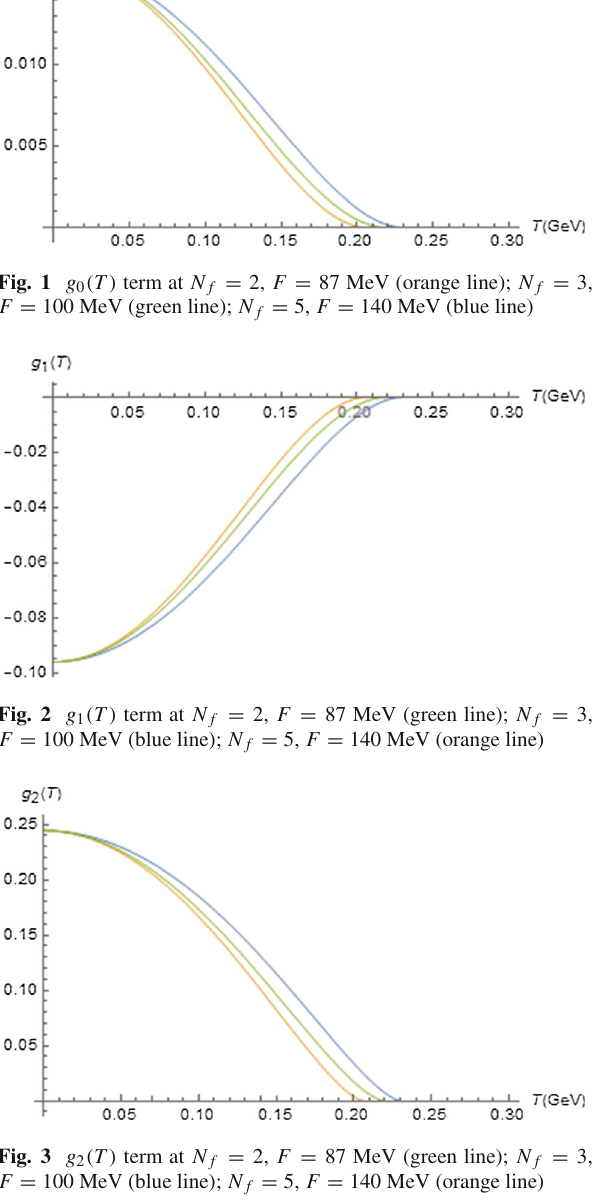
temperature and near the T c temperature it becomes zero.